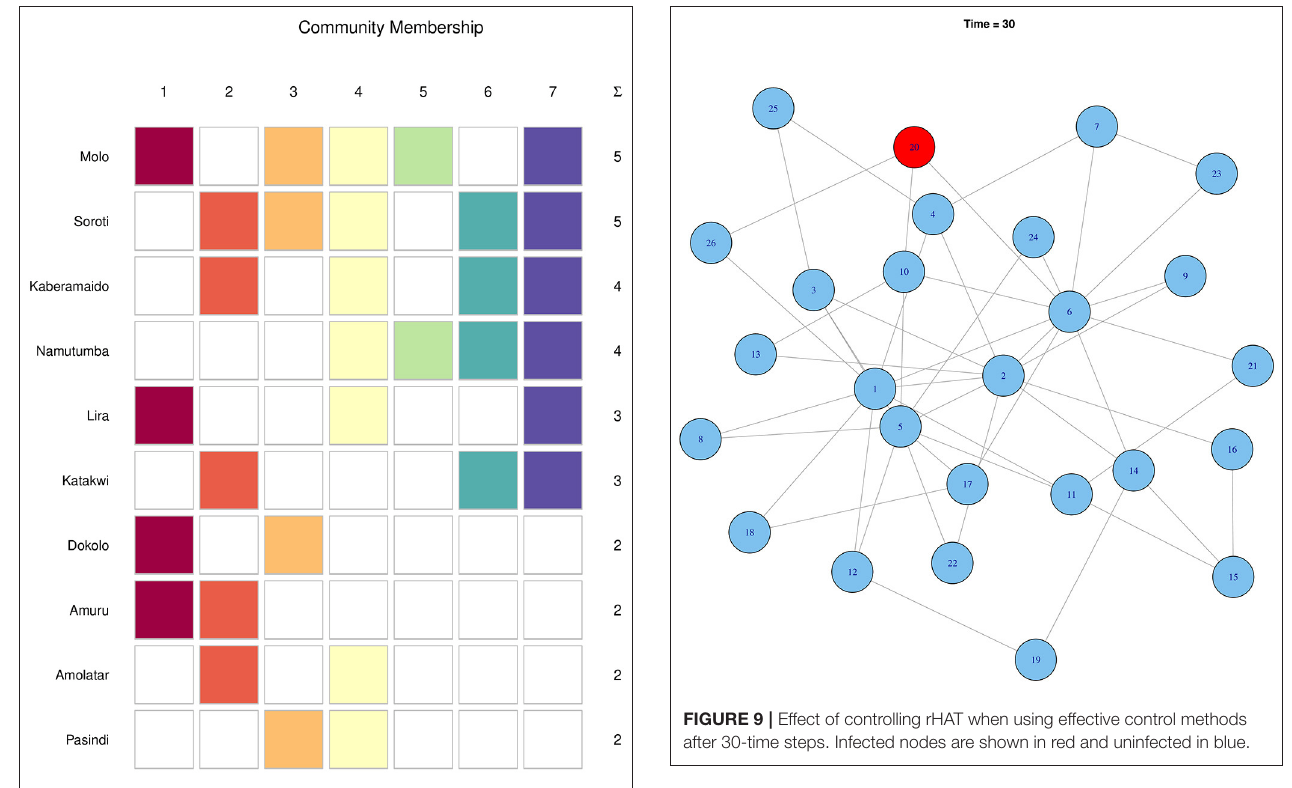
livestock movements through formal livestock markets and restocking in disease spread. Uganda is a source of meat for the East African community, Democratic Republic of the Congo, and Southern Sudan